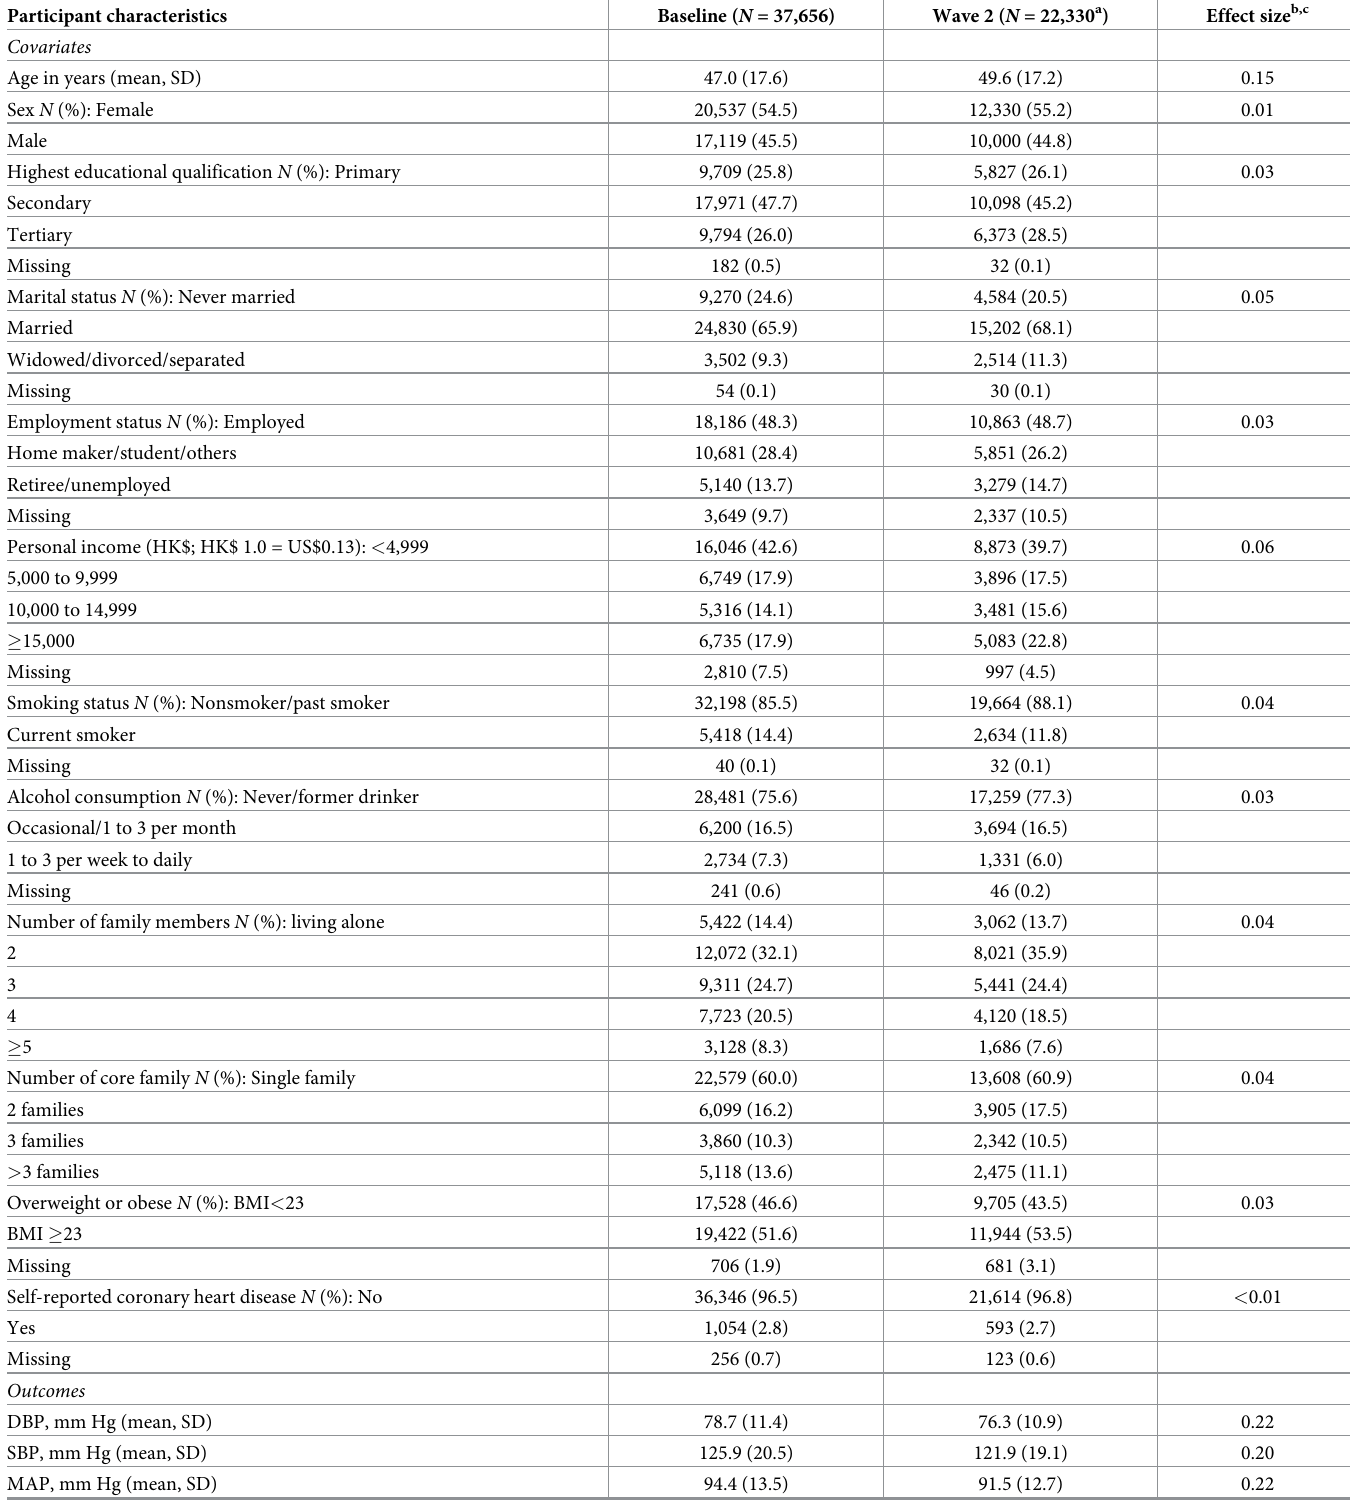
Table 1. Descriptive characteristics of the longitudinal